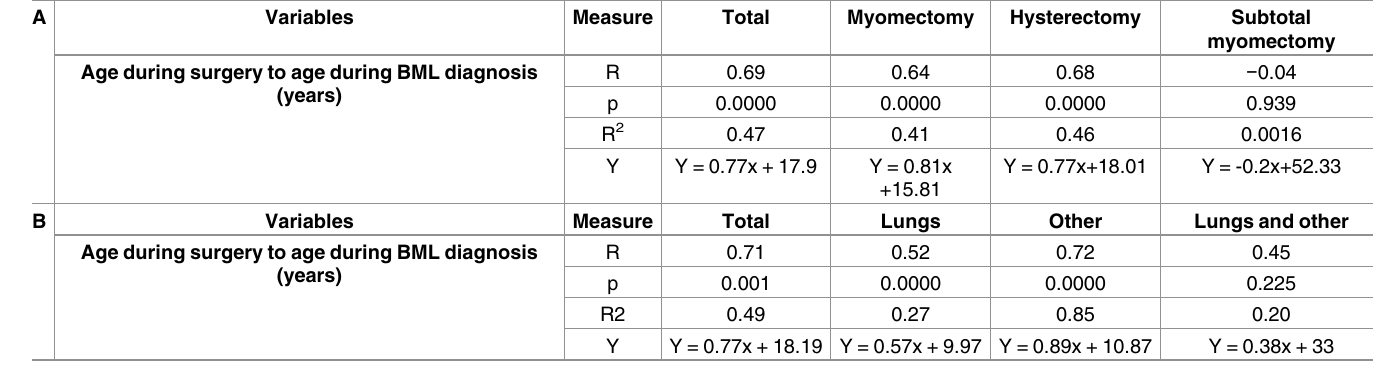
Table 3. Results of the analysis of regression, in general, and in groups determined by the type of surgery and the site of metastasis.